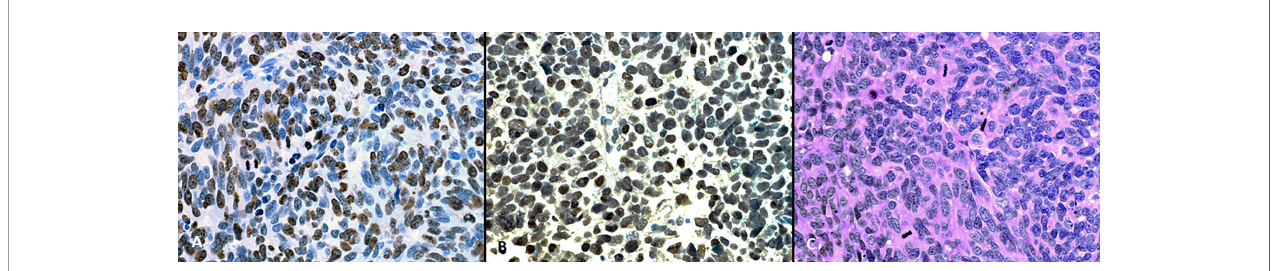
FIGURE 2 | (A) On hematoxylin and eosin staining tumor cells have scant to moderate amount of eosinophillic cytoplasm, and irregular nuclei with “ salt and pepper ” chromatin. Brisk mitotic activity can be seen. (B) On immunohistochemical staining tumor cells nuclei strongly and diffusely express TTF-1. (C) The proliferative Ki-67 index is high (magni fi cation, x400).